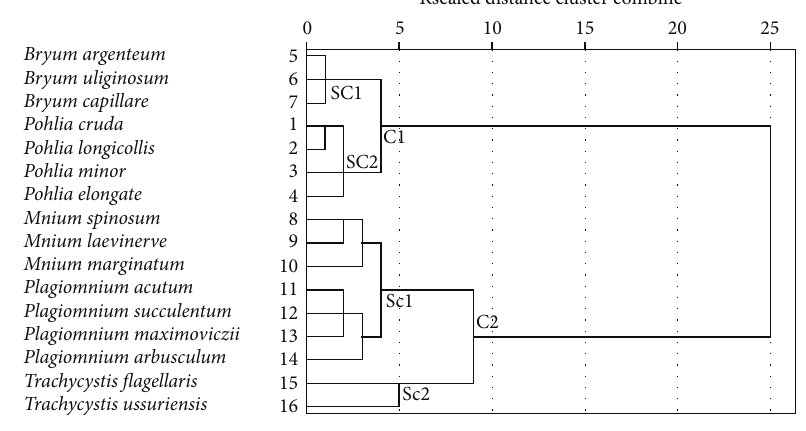
Figure 2: Rescaled distance cluster